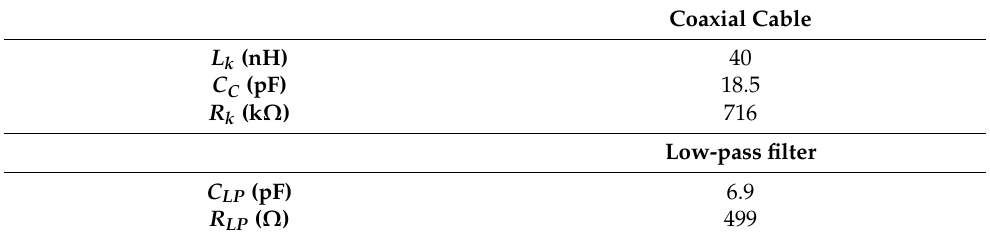
Table 2. Coaxial cable and low-pass filter equivalent circuit